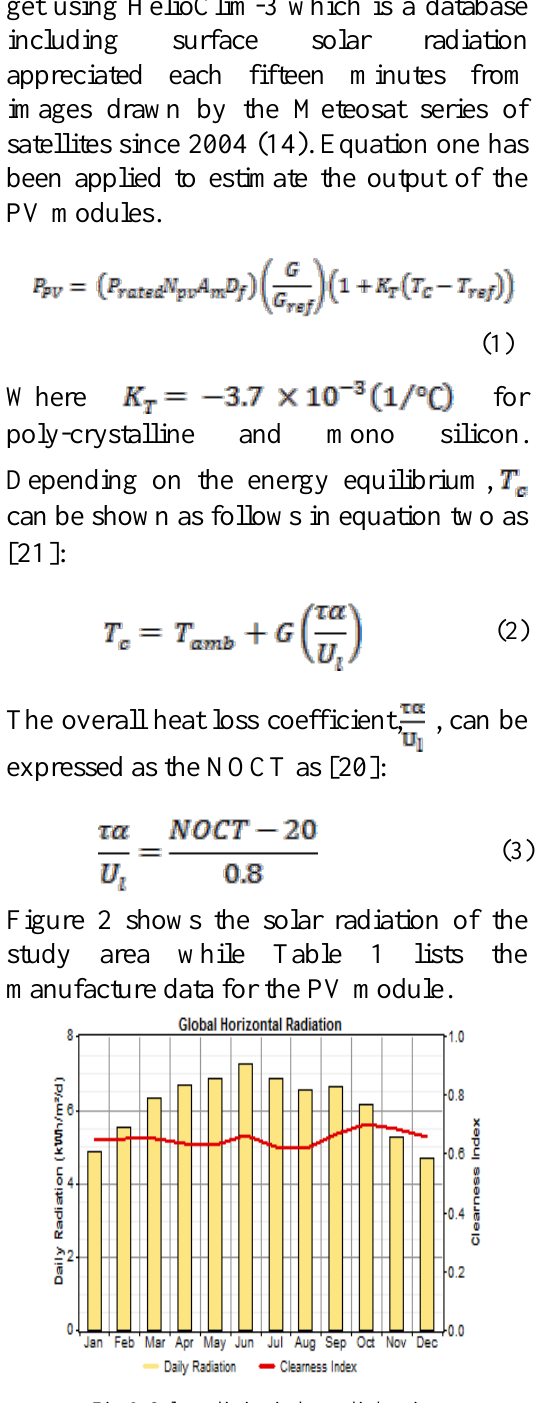
Fig. 2: Solar radiation in the studied region.